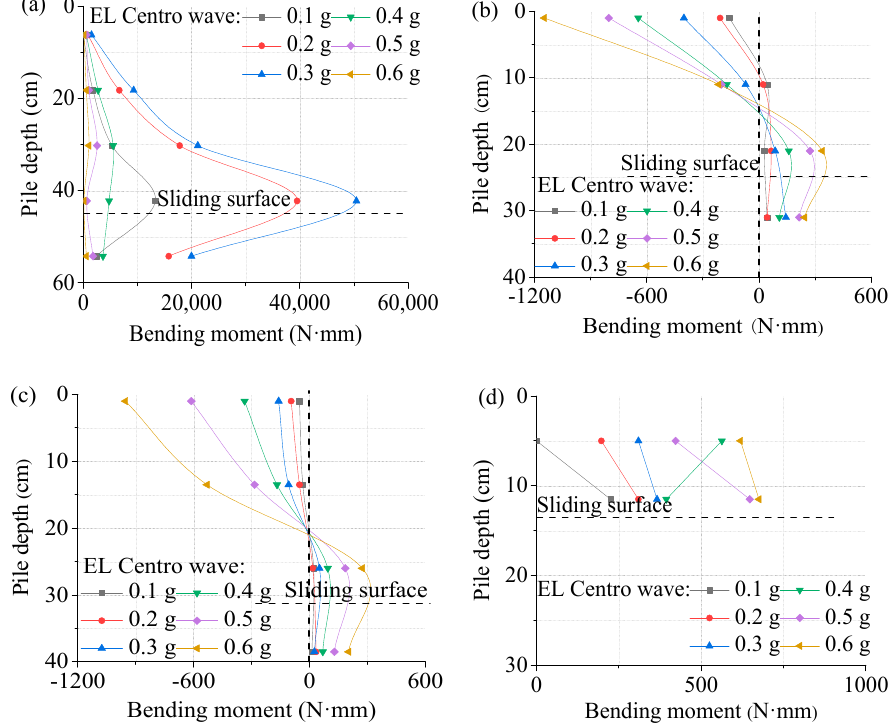
Figure 15. Distribution of bending moment. ( a ) Back-row anti-slide pile; ( b ) back-row pile of bridge foundation; ( c ) front-row pile of bridge foundation; ( d ) front-row anti-slide pile.